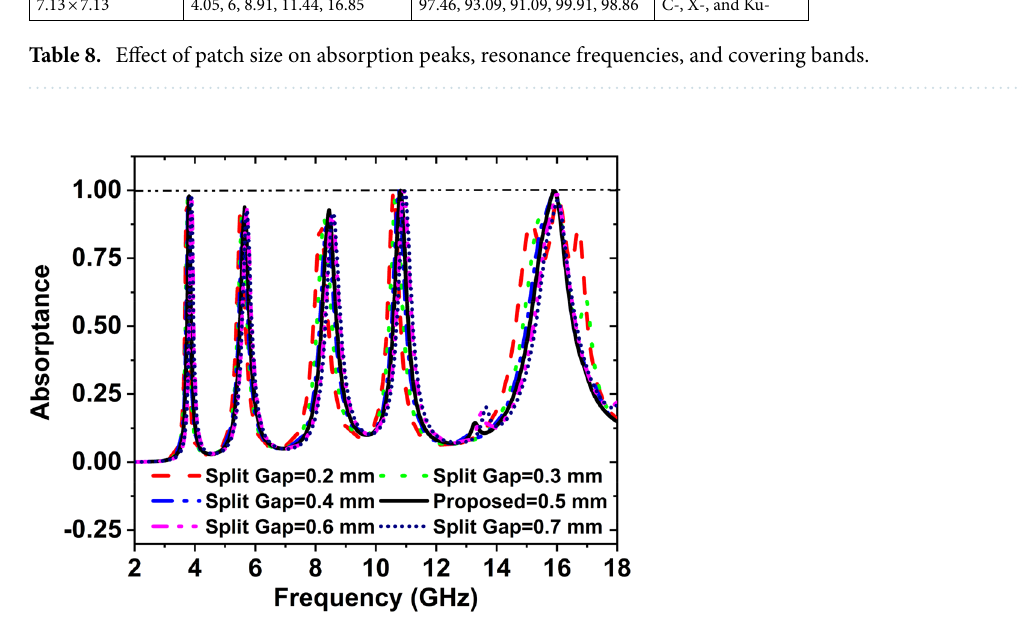
Figure 19. Change of absorption with the variation of the split